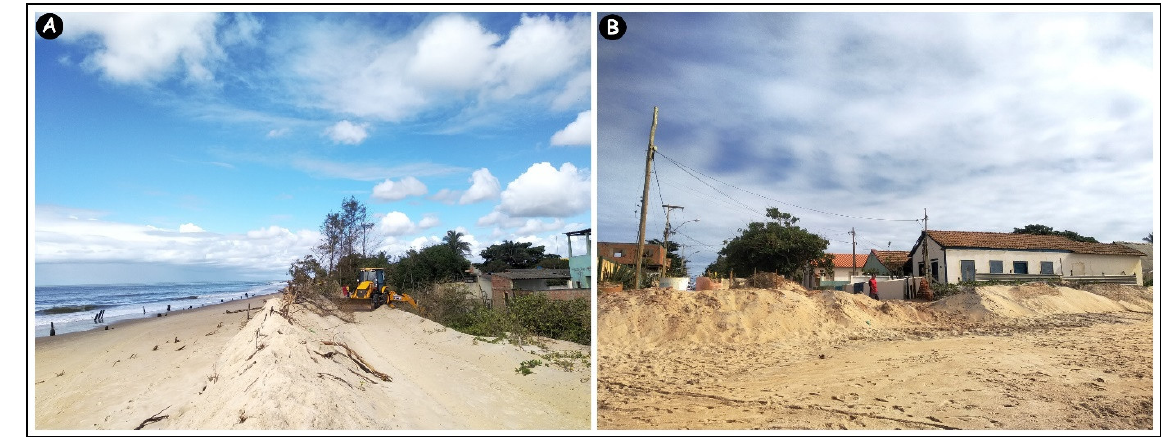
Figure 9. Example of temporary containment to delay the contact of waves with the dwellings. ( A ) Excavator creating a protective barrier using sediments from the beach itself (N-S view); ( B ) artificially created sediment barrier to protect houses that are on the front lines of the erosive process (SE-NW view). For the locations of the photos, see Figure 8. Photo by: L. Lämmle, 2021.